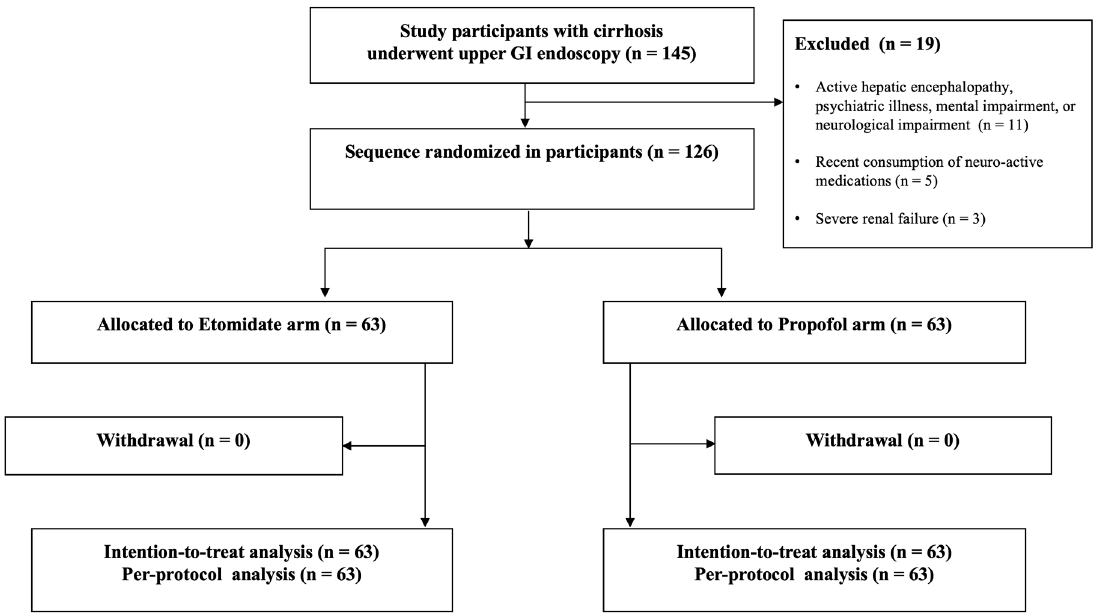
Figure 1. Flow chart showing patient allocation and progression throughout the randomized trial. GI, gastrointestinal; SaO 2 , arterial oxygen saturation.